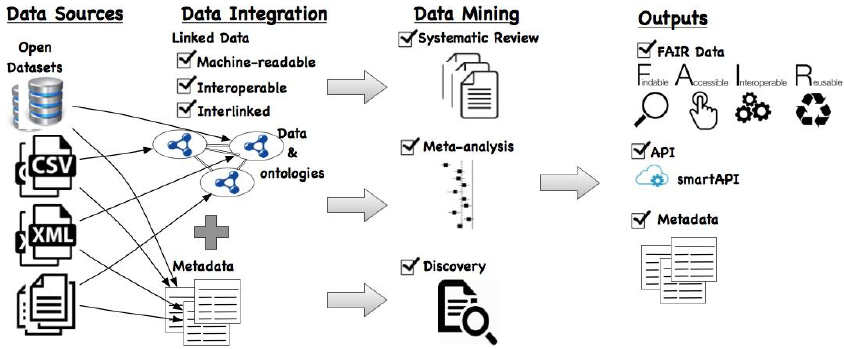
Figure 1. Proposed Framework for describing the flow of data from sources to outputs.